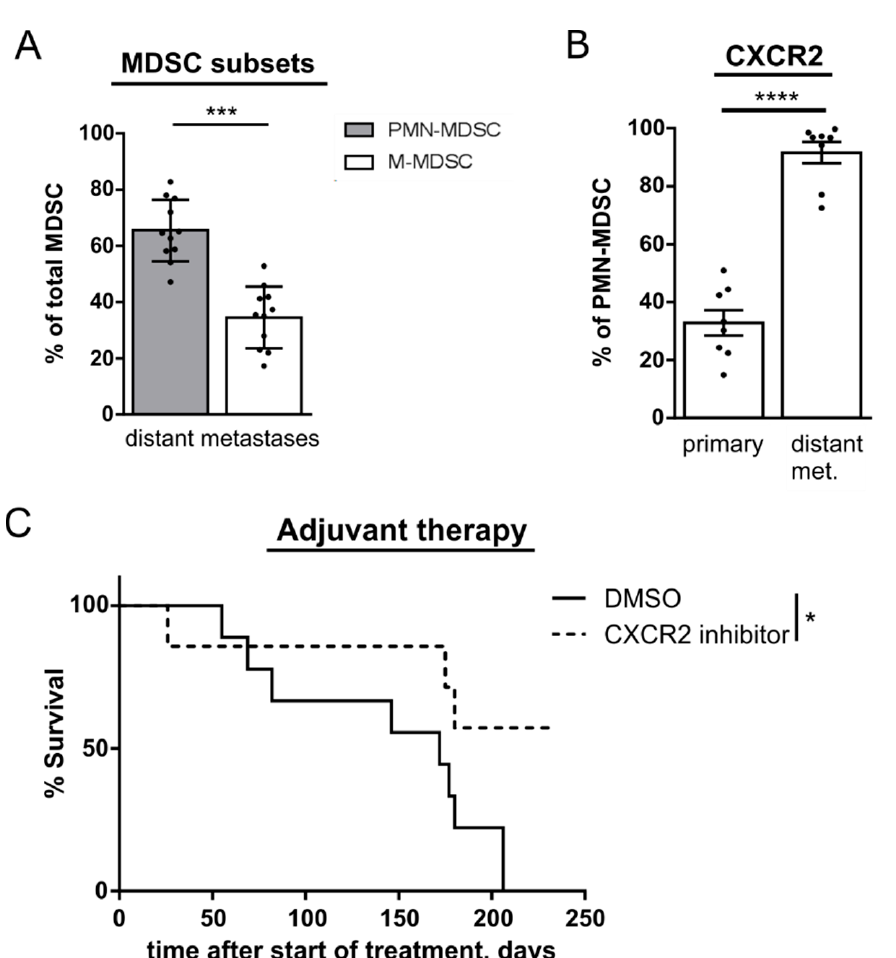
Figure 6. Accumulation of PMN-MDSC in melanoma metastasis and effect of adjuvant anti-CXCR2 therapy on mouse survival. C57BL/6 mice were transplanted intradermally with the fragments of primary tumors from RET transgenic mice followed by tumor resection at day 21 after transplantation. ( A ) PMN- and M-MDSC were analyzed in distant metastases (lungs and liver) of melanoma bearing mice by flow cytometry. Data are presented as the percentage of PMN- or M-MDSC among total MDSC (mean ± SEM; n = 11). ( B ) PMN-MDSC in primary skin tumors and distant metastases. Data are shown as the percentage of these cells among total MDSC (mean ± SEM; n = 8). ( C ) At day 7 after tumor resection, mice were injected i.p. with the CXCR2 inhibitor SB265610 (2 mg/kg) or the control DMSO solution (control group) twice a week for six weeks. Survival of mice (7–10 mice/group) is shown as Kaplan–Meier curves. * p < 0.05, *** p < 0.001, **** p <